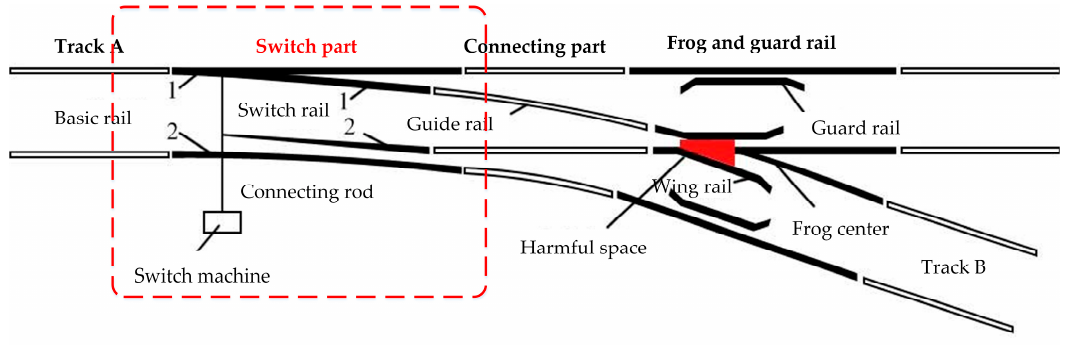
Figure 2. Railway turnout system. The basic structure of a single turnout system and the location of mechanical components.